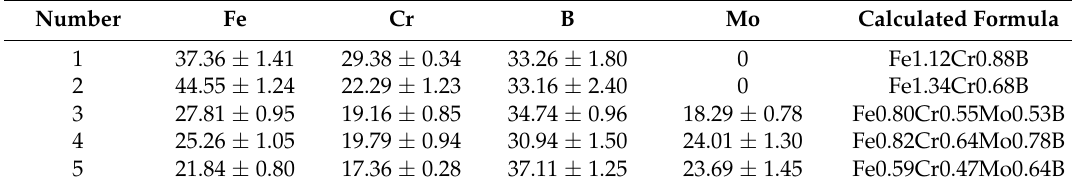
Table 2. The average composition (in at.%) of M 2 B-type boride (M = Fe, Cr, Mo) in Fe-Cr-B cast steels measured by using wavelength dispersive X-ray (WDX) at each point in Figure 3a–d.